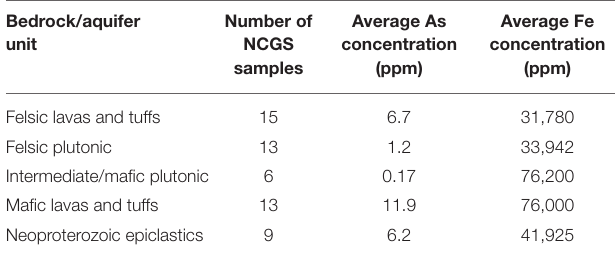
Number of samples